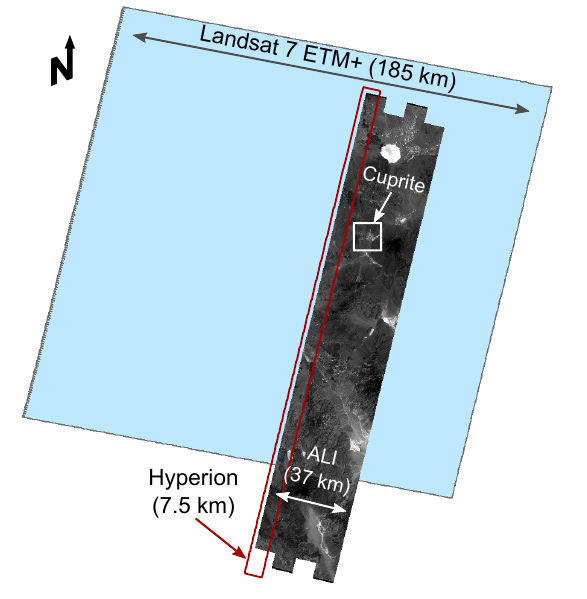
Figure 1: Locations of EO1-Hyperion, ALI and Landsat 7 ETM+ scenes used in this study